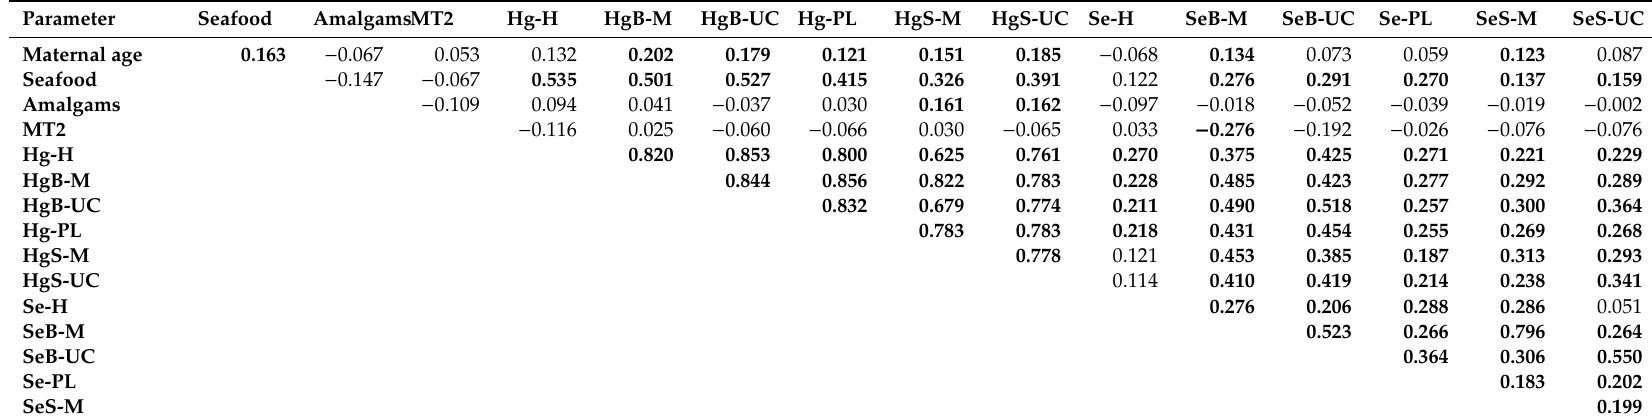
Table 4. Spearman’s correlation coe ffi cients ( ρ s ) for relationships between the frequency of maternal seafood / fish consumption, number of dental amalgams, and biomarkers of mercury (Hg) and selenium (Se) determined in the studied mother–infant pairs from Croatia ( n = 94–281)